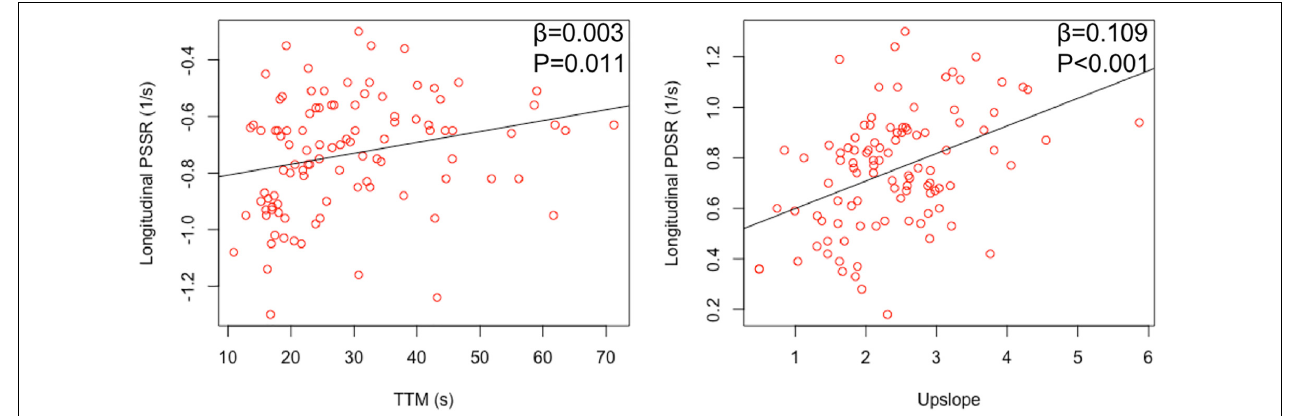
FIGURE 4 | Relationship between myocardial perfusion and LV deformation in hypertensive patients.